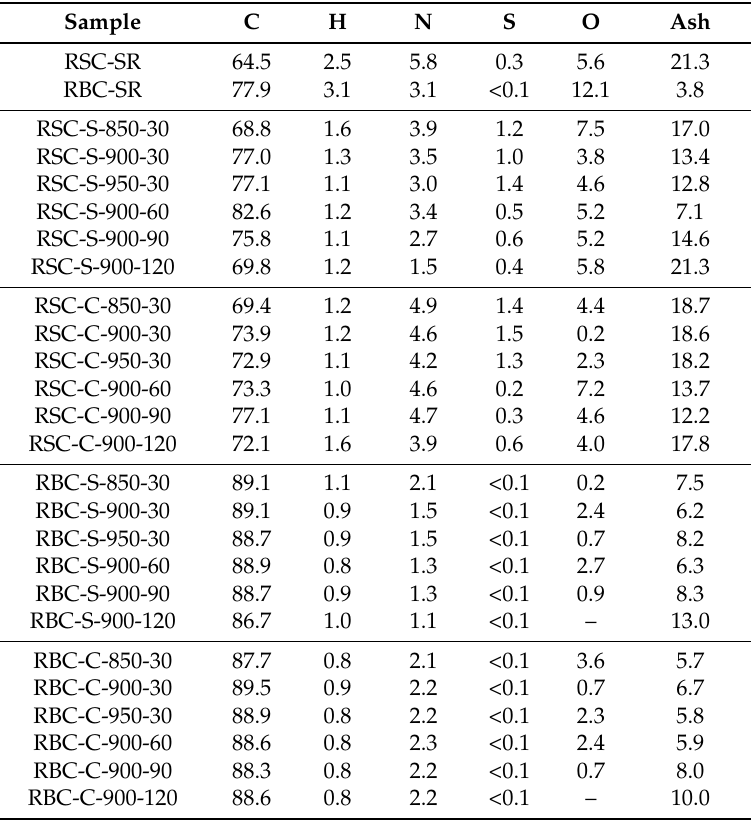
Table 3. Elemental analysis (wt %, air-dried basis) of the solid residues (SR) and the ACs produced from RSC (after HCl washing) and RBC using various activation